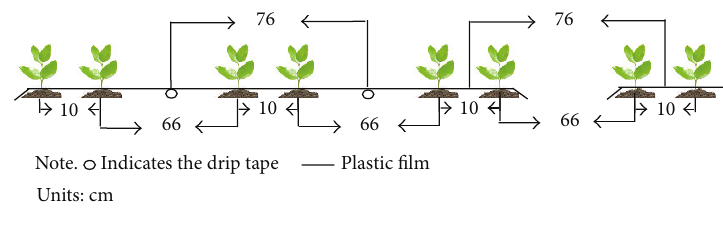
Figure 1: Diagram of row and hill spacing in experiments 1 and 2.